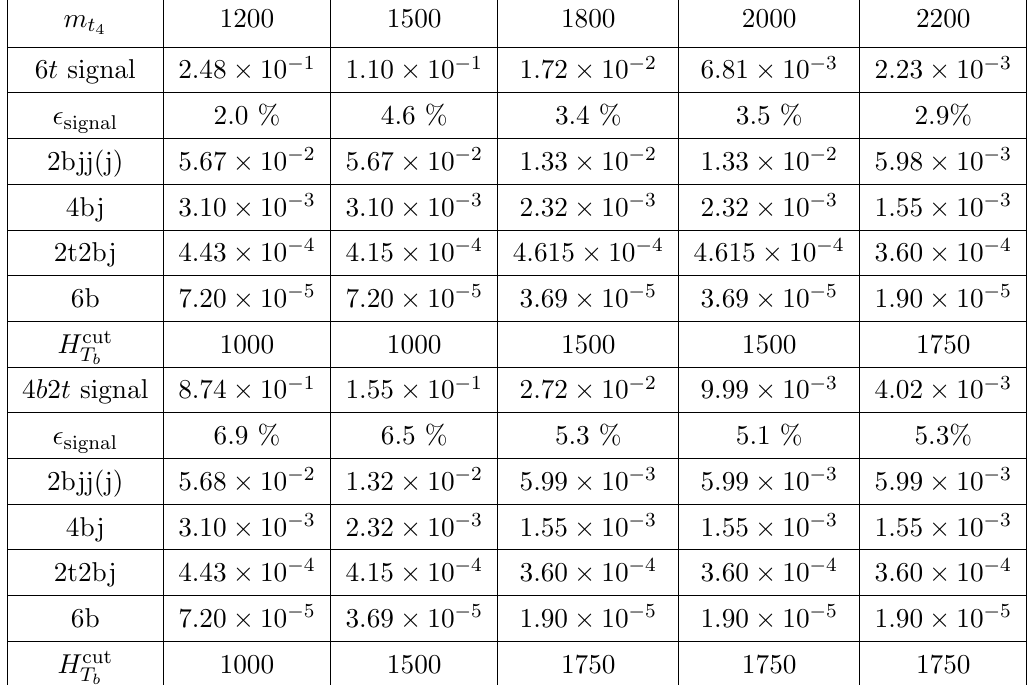
Table 4 . Signals pp t 4 t 4 t 4 t 4 6 t , pp 4 b 2 t and background (cid:12)ducial cross sections in units ! ! ! ! of fb in the 5b analysis. For each t 4 mass hypothesis, the optimized cuts are listed in the last row for integrated luminosity L = 3 ab (cid:0) 1 . The signal e(cid:14)ciency of the cuts ( (cid:15) ) is also presented. All results are presented using the 1b/2b-tagging working point ( (cid:15) 1 b ; (cid:22) (cid:15) 2 b ) = (0 : 9 ; 0 : 5).